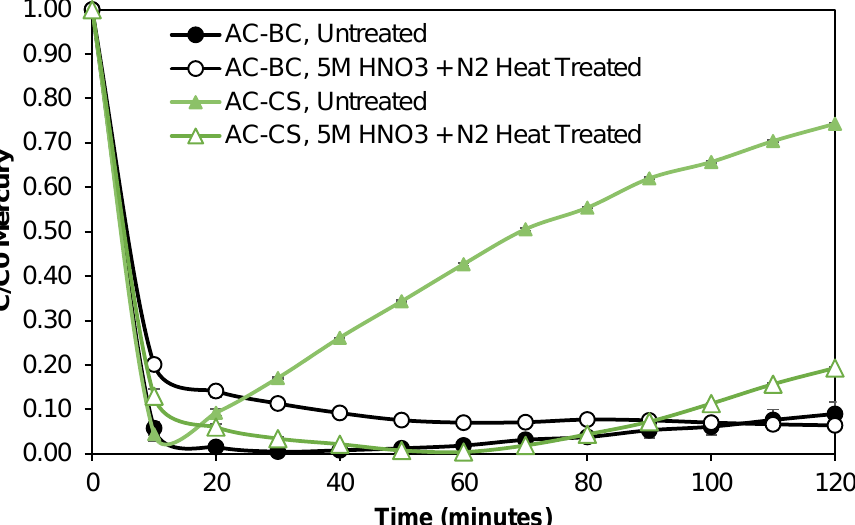
Figure 12. Mercury removal for nitric acid and nitric acid post-treated with nitrogen gas using bituminous coal-based and coconut-based activated carbons.